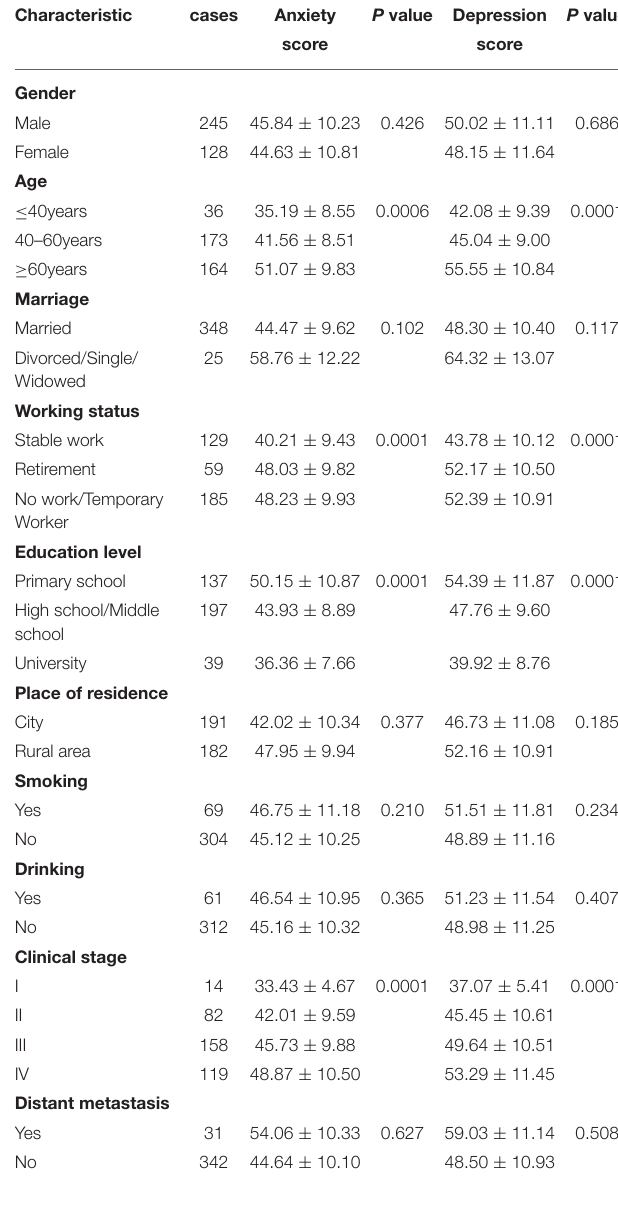
TABLE 2 | Univariate analysis of anxiety and depression in 373 tumor radiotherapy patients.